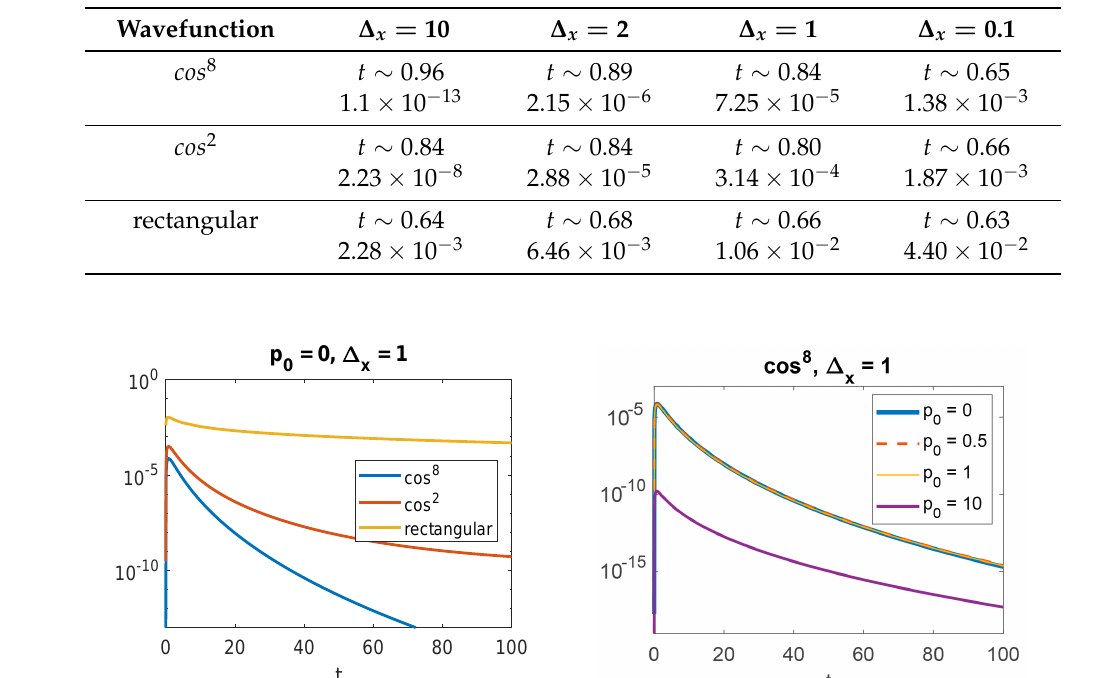
Table 2. Time for which the fraction of the probability density lying outside the light cone is maximal, along with the corresponding value of that fraction, for different initial wavefunctions (all with p 0 = 0).